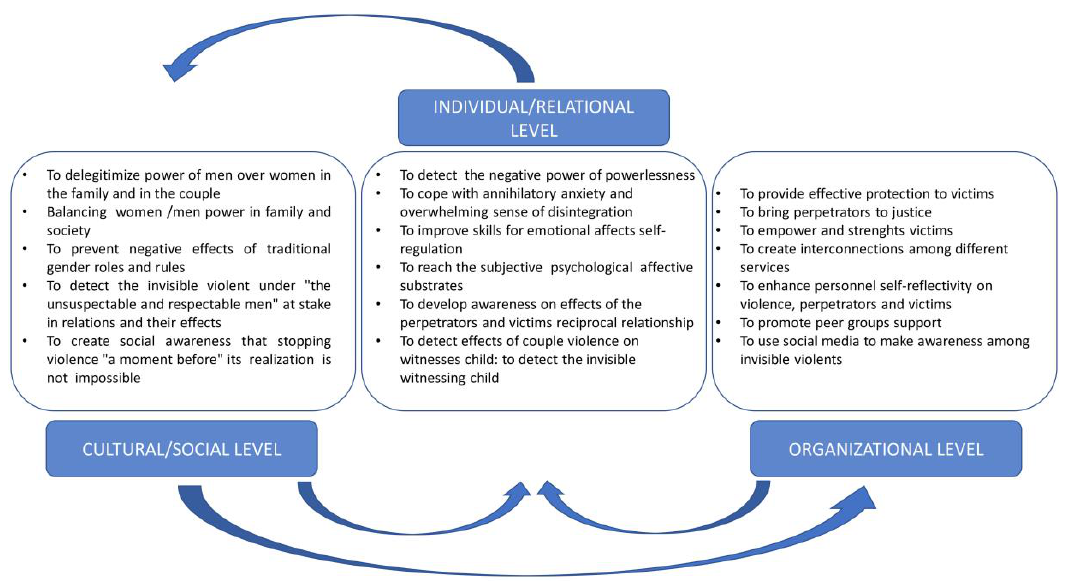
Figure 1. The ecological model and operationalization of goals and actions at different levels.